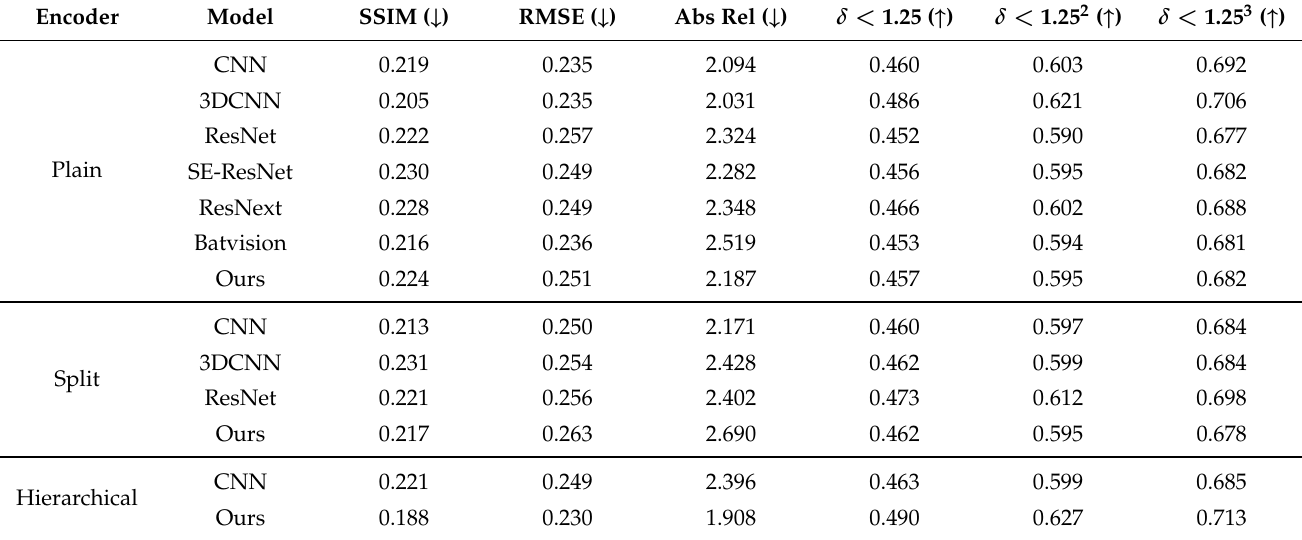
Table 2. Quantitative results